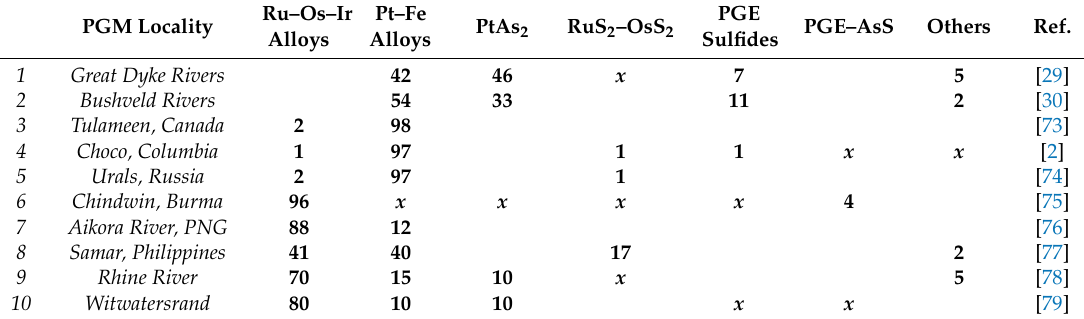
Table 1. PGM proportions (in %) of placers originating from layered intrusions (1 + 2), Alaskan-type intrusions (3–5), ophiolite-related localities (6–8), the Rhine River (9), and the Witwatersrand gold paleoplacer (10). At some localities, no exact numbers are available, and x means = present. Abbreviations: PtAs 2 = sperrylite; RuS 2 –OsS 2 = laurite-erlichmanite; PGE-sulfides = various PGE-sulfides; PGE–AsS = various